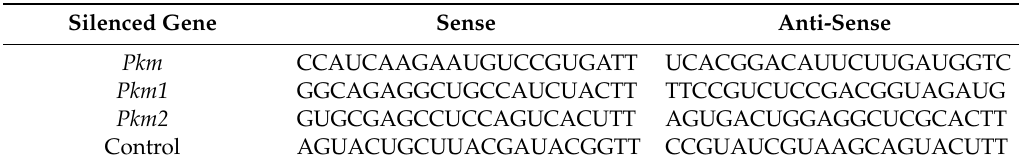
Table 2. siRNA information.